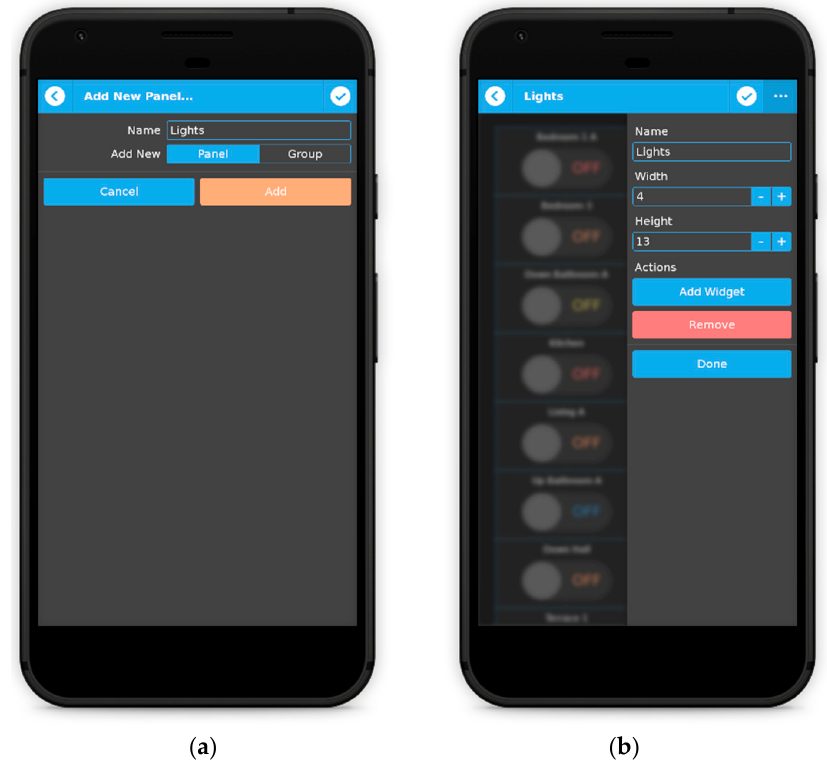
Figure 4. Creating panels ( a ) and groups of panels ( b ).